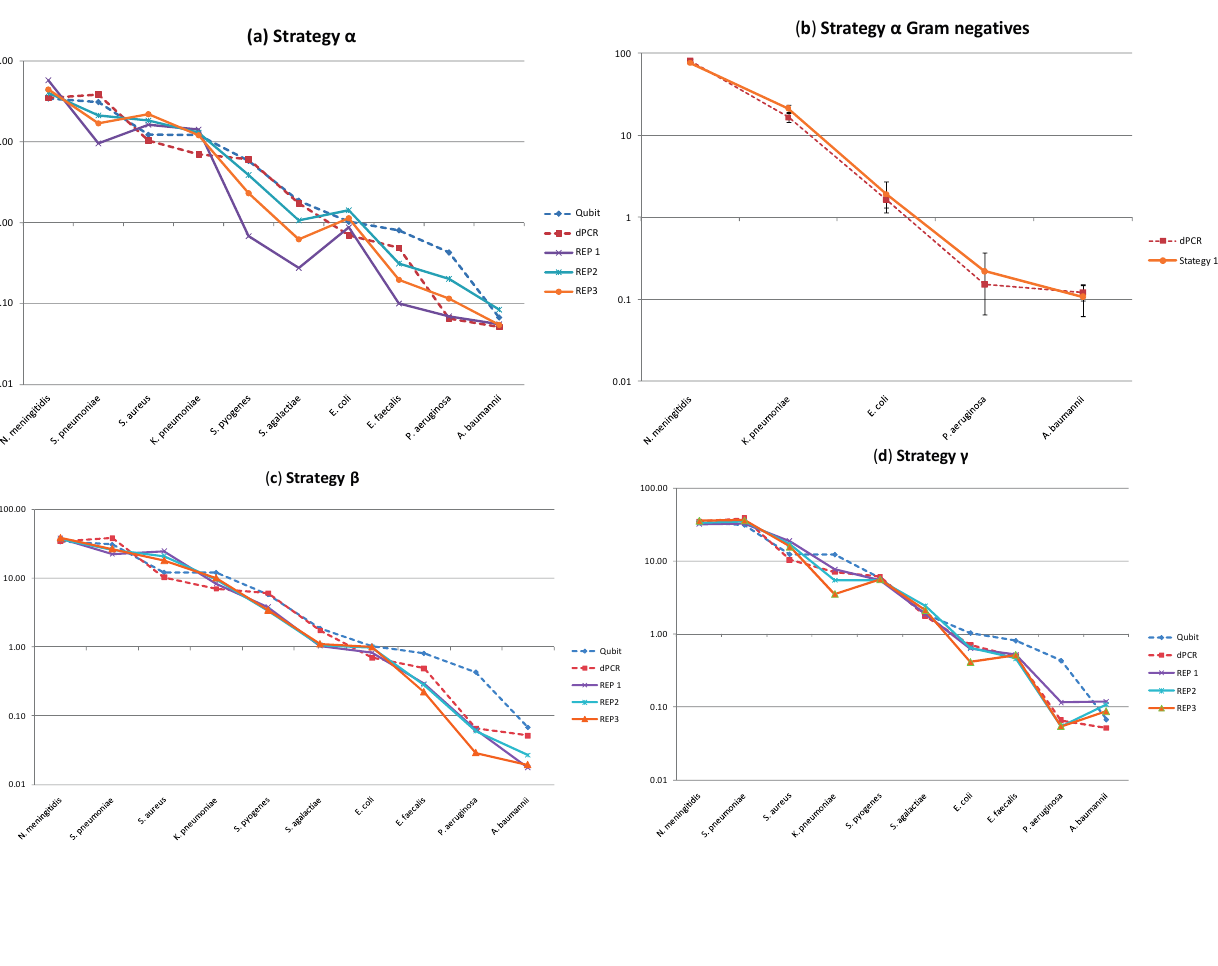
Figure 3. Relative copy number, expressed as a percentage of the metagenomic control material, from amplicon sequencing using different strategies amplifying the 16S rRNA. The error bars refer to the 95% confidence interval. Dashed blue line with a triangle represents the Qubit value, the dark red dashed line with a box represents the dPCR value, the purple line with cross is replicate 1, blue line with asterix replicate 2 and orange line with triangle replicate 3 of the sequencing approaches. ( a ) The α strategy which targets the Gram-negative members of the MCM; ( b ) expanding the results for the Gram-negative species and ( c ) the β strategy using multiple forward primers with a single reverse primer to target 16S rRNA variable regions 1 and 2; ( d ) The γ strategy using a degenerate primer and ( e ) δ strategy using the ability of T to bind to G and vice versa targeting 16S rRNA variable regions 4, 5 and 6; ( f ) Expresses relative composition of the MCM as determined by whole genome